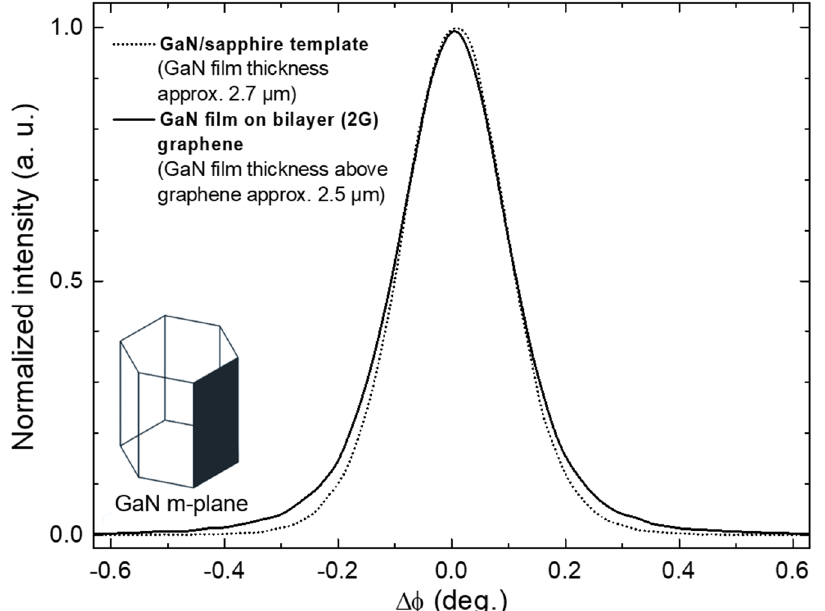
Figure 6. XRD rocking curve of (1100) plane GaN epilayer grown on bilayer graphene (solid line). For comparison, an analogous rocking curve of the GaN/sapphire template is provided (dotted line).